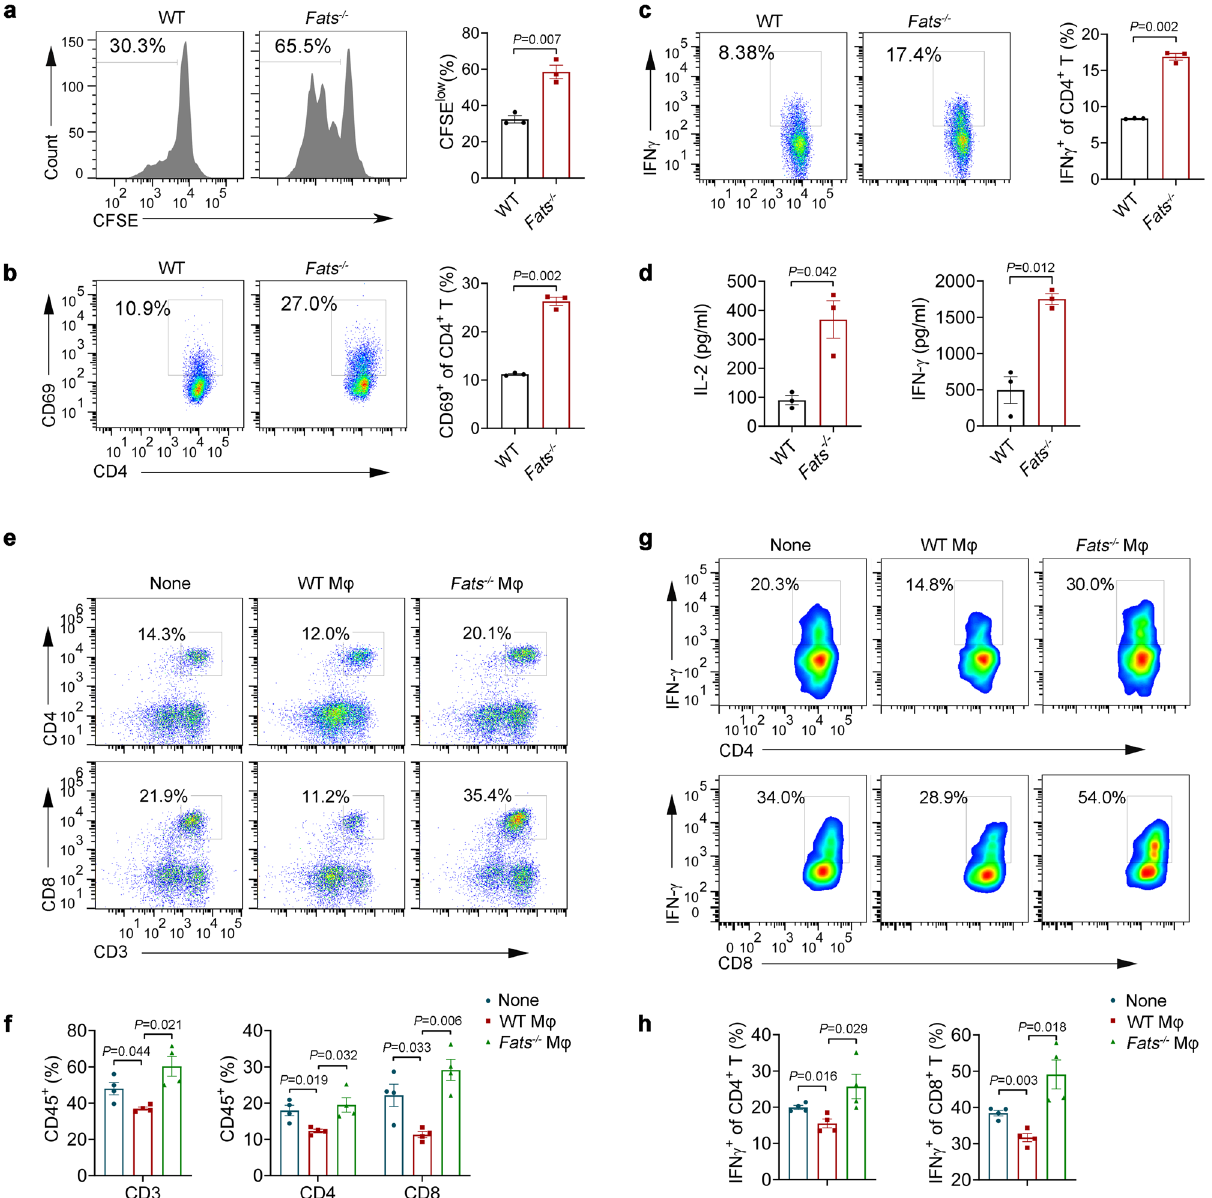
Fig. 6 Fats − / − macrophages promote Th1 responses. a – d BMDMs from WT and Fats − / − mice were preincubated with soluble ovalbumin (OVA) overnight and cocultured with CFSE-labeled CD4 + OT-II T cells. a The proliferation of CD4 + OT-II T cells was analyzed using fl ow cytometry after coculture for 72 h. Flow cytometric analysis and quanti fi cation of CD69 ( b ) and IFN- γ ( c ) expression in CD4 + OT-II T cells after coculture for 72 h. d Supernatants were collected from BMDMs cocultured with OT-II CD4 + T cells after 3 days, and the IL-2 and IFN- γ concentrations were analyzed using ELISA kits ( n = 3 biologically independent samples). e – h BMDMs from WT and Fats − / − mice were transferred into recipient WT mice prechallenged with B16 cells. On day 20, tumors were isolated, and fl ow cytometry was used to determine the frequencies of tumor-in fi ltrating CD3 + T, CD4 + T, and CD8 + T cells among CD45 + cells ( e , f ) as well as to assess IFN- γ production in tumor-in fi ltrating CD4 + T and CD8 + T cells in B16 tumors ( g , h ) from recipient WT mice treated without (None) or with WT BMDMs (WT M φ ) or Fats − / − BMDMs ( Fats − / − M φ ) ( n = 4 mice per group). Data are presented as mean